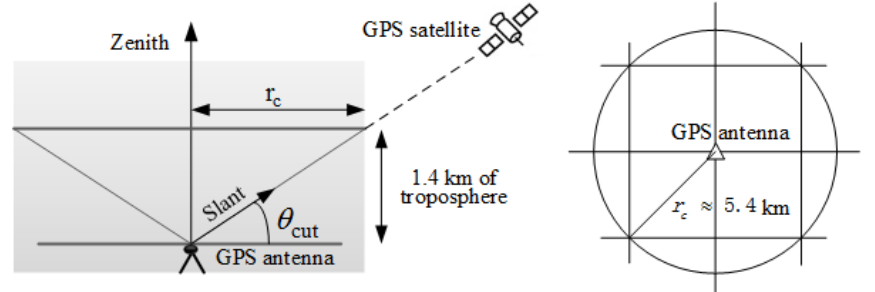
Figure 5. GPS receiver records a satellite signal at a cut-off elevation angle θ cut defining a cone-like tropospheric section above the antenna. For θ cut = 15 ◦ , r c ≈ 5 . 4km. The (cid:49) PWV estimated by InSAR pixels within this circle are averaged to emulate GPS-based (cid:49) PWV.